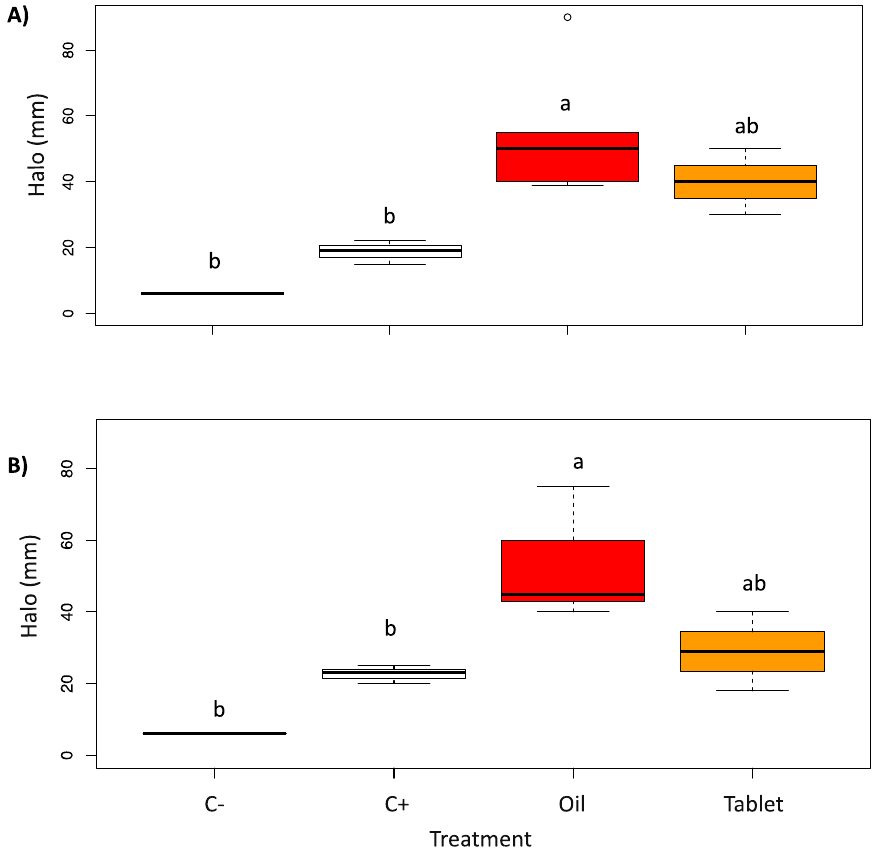
Figure 5. Boxplots of the growth inhibition halo (mm) induced by T. vulgaris on C. albicans ( A ) and C. glabrata ( B ). C- = negative control (1,4-dioxane); C+ = positive control (clotrimazole); Oil = T. vulgaris essential oil; Tablet was produced adding T. vulgaris essential oil with cyclodextrin-powder. Different letters in the figure indicate significant differences between treatments at p < 0.05.